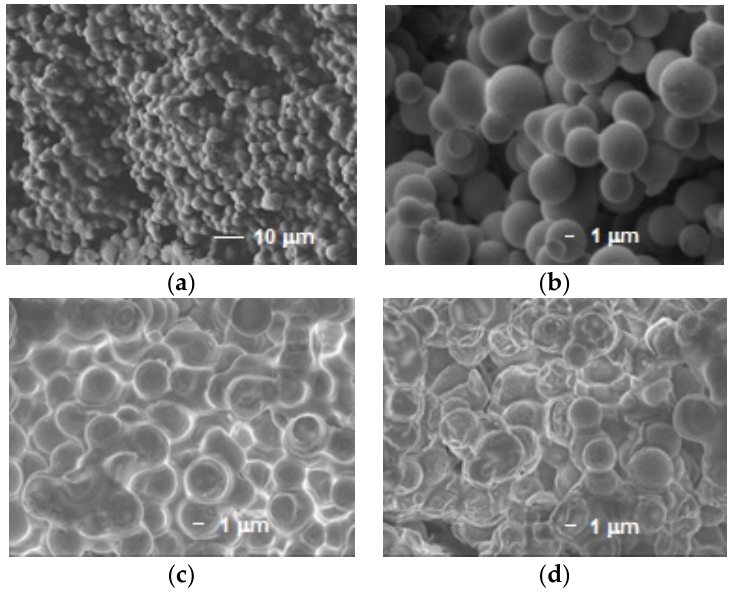
Figure 6. SEM images of the Ni plated AM4-HDA porous polymer I-10w-60d by Method 1, monomer concentration in reaction solution: 10 wt %, plating time: ( a ) original, ( b ) 5 min, ( c ) 10 min, and ( d ) 20 min.